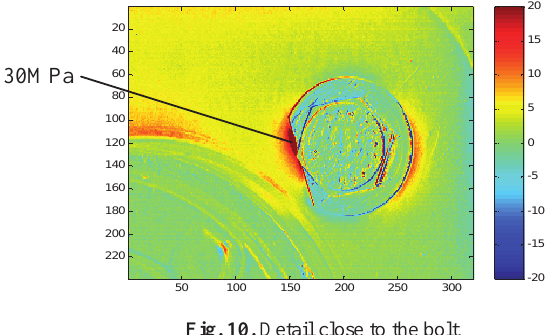
Fig. 10. Detail close to the